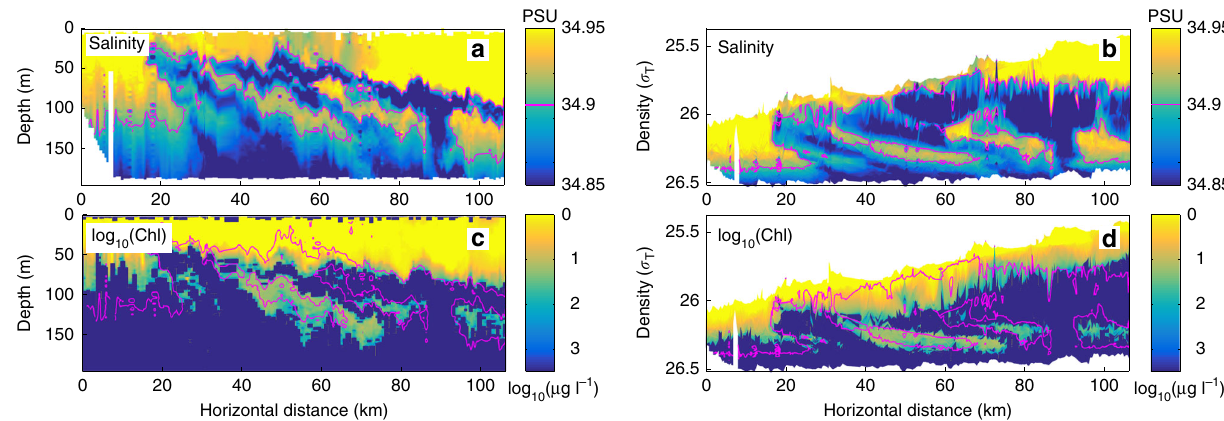
Fig. 3 Subsurface submesoscale phytoplankton tongues. a Salinity and c chlorophyll concentration vs. depth measured along one glider transect perpendicular to the Peruvian coast, 23 – 29 October 2008. In b and d , the same data are plotted using density as the vertical coordinate. The magenta contour in all plots marks the 34.9 PSU salinity contour The horizontal resolution between pro fi les is 1 km, with 1 m vertical resolution. The section exhibits a series of interleaved tongues of high salinity/high chlorophyll water extending to 150 m depth — well below the euphotic zone. The salinity/chlorophyll tongues are ~10 km wide, and <50 m thick, forming submesoscale phytoplankton patches bounded by high spatial gradients. The fact that the layers slope across isopycnal surfaces at depth suggests that they were not formed by simple along-isopycnal subduction from the surface; other possibilities include subduction combined with surface heating, and vertical and horizontal shearing at the front. Adapted from Pietri et al. 69